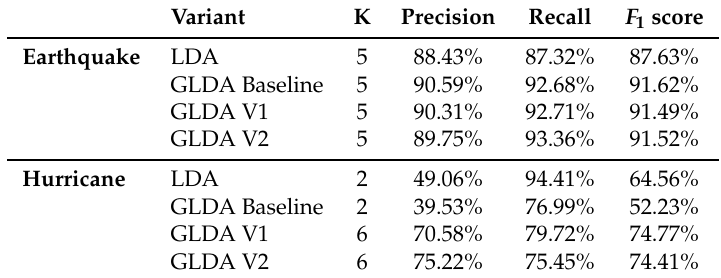
Table 7. Detailed classification results including precision and recall on the earthquake dataset (top) and the hurricane dataset (bottom) based on the best average F 1 score of the five runs for each variant.